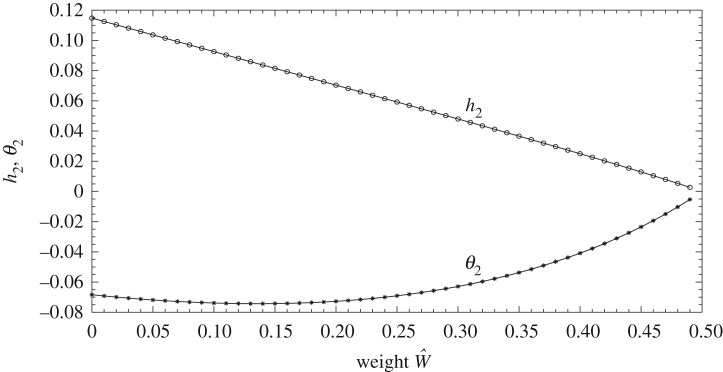
The coefficients h2, θ2 from (6.4a,b) in the large-time response versus scaled weight: 0<M^g^<0.5 for σ=0.5, M^=1. This indicates the range for lift-off and fly-away for any body shape: see text. For scaled weights over the value 0.5 fly-away cannot occur.